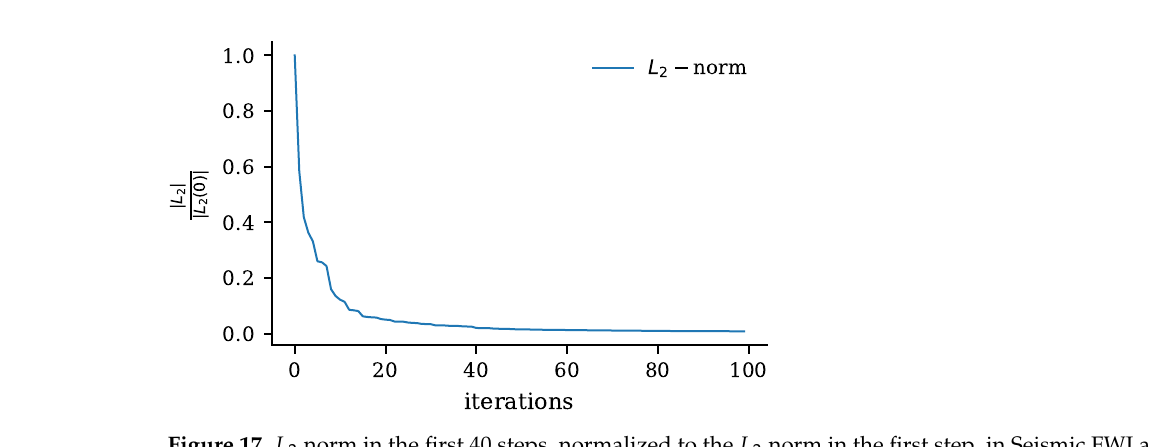
Figure 17. L 2 norm in the first 40 steps, normalized to the L 2 norm in the first step, in Seismic FWI a spherical inclusion in